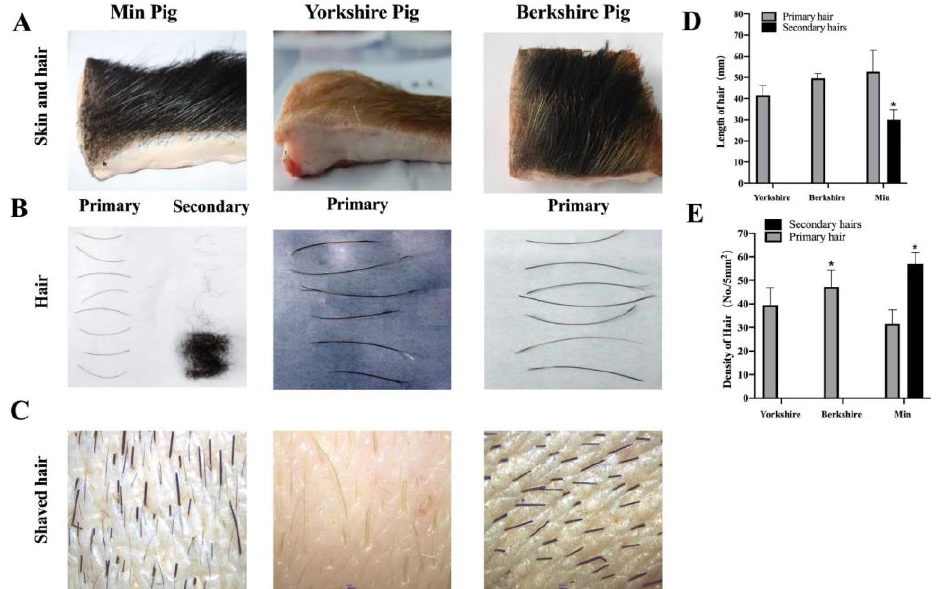
Figure 1. The hair phenotype for three breeds of Min pig, Yorkshire pig, and Berkshire pig. ( A ) Skin and hair phenotypic observation for three breeds. ( B ) Primary hair and secondary hair phenotypic observation for three breeds pigs. ( C ) The shaved hair of three breeds pig were observed with the stereoscopic microscope. ( D ) The length of primary hairs and secondary hairs were calculated from three breeds. ( E ) The number of primary hairs and secondary hairs were analyzed for each breed in 5 mm 2 . * p <